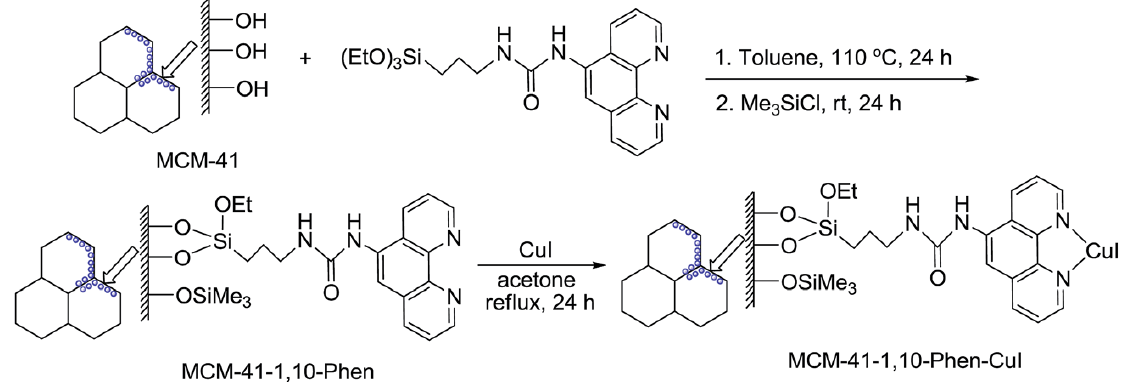
Figure 25. Preparation of MCM-41-1, 10-phen–CuI. Reproduced with permission from [33].